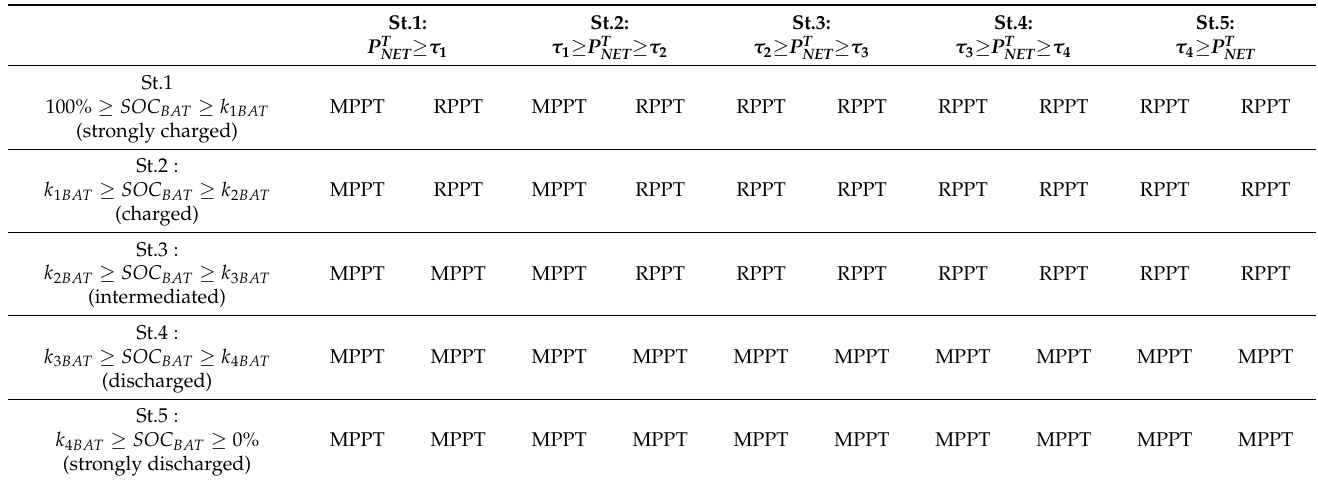
Table 5. EMS control rules for the PV